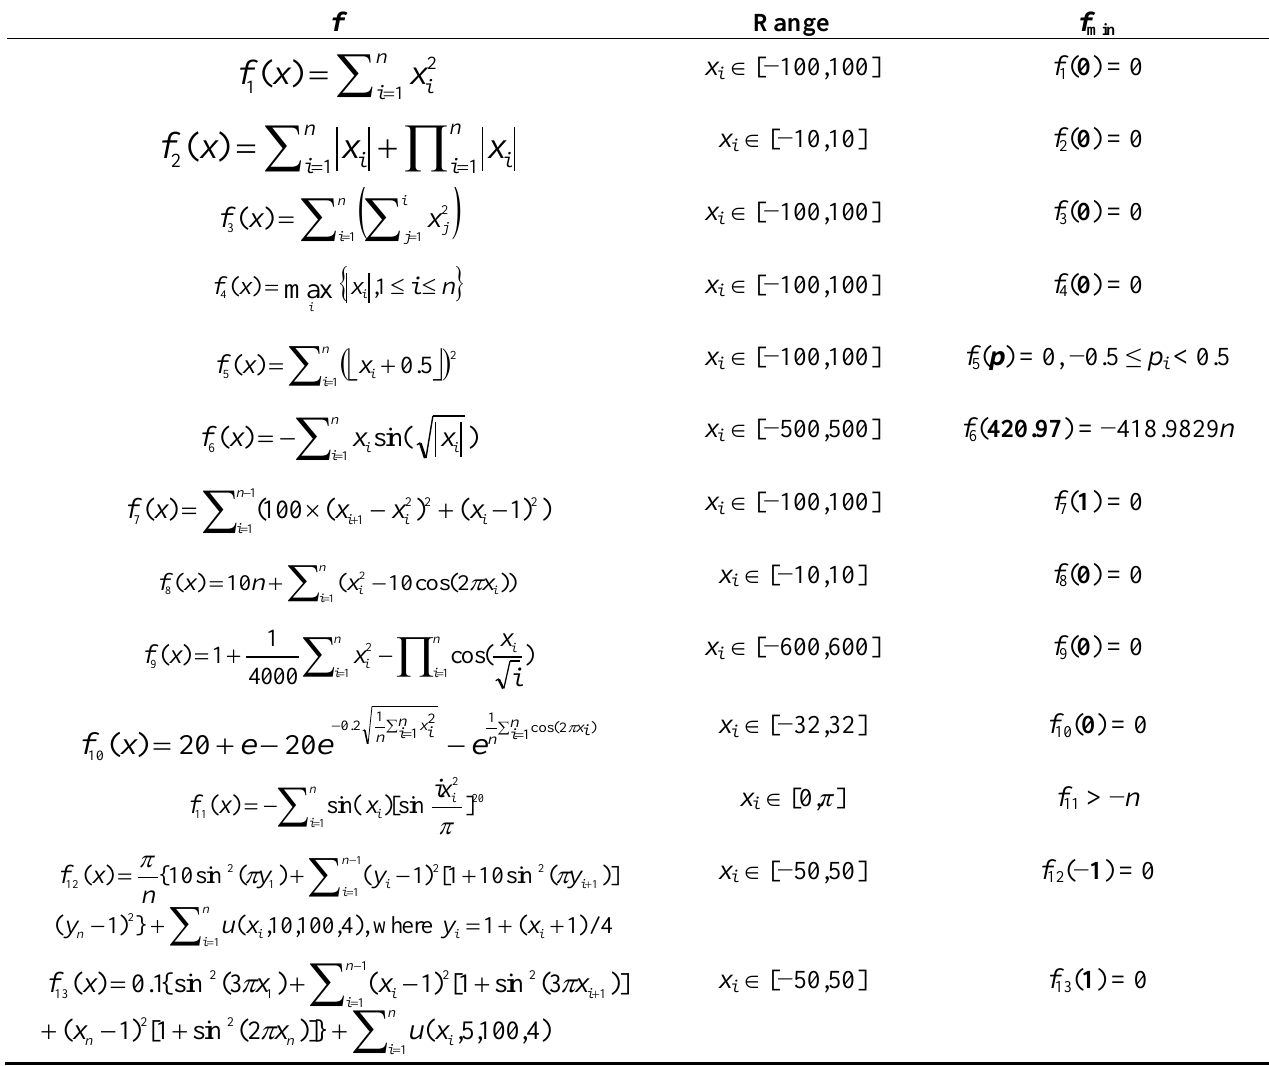
Table 1. Benchmark